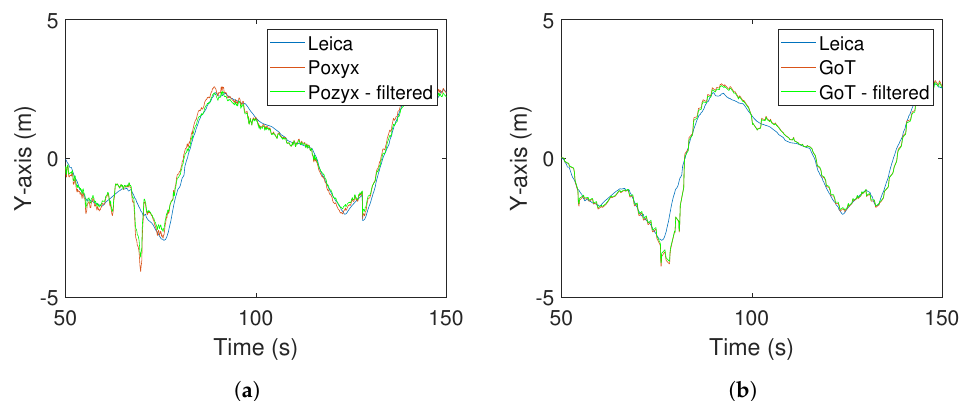
Figure 16. Y-direction traces after pre-filtering with and without Wiener filtering. ( a ) Leica/Pozyx Y-direction traces in time domain. ( b ) Leica/GoT Y-direction traces in time domain.